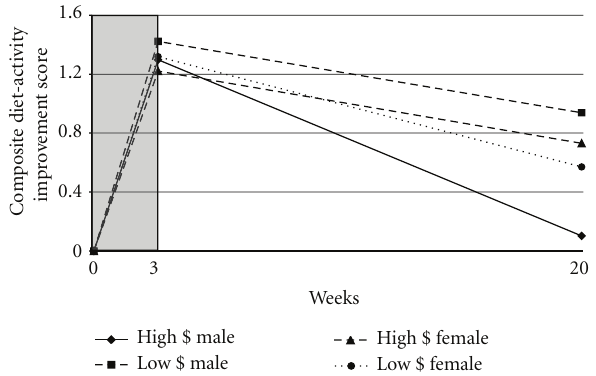
Figure 2: Financial motivation x gender predicting composite diet-activity improvement score. $: financial motivation. high: top quartile; low: bottom